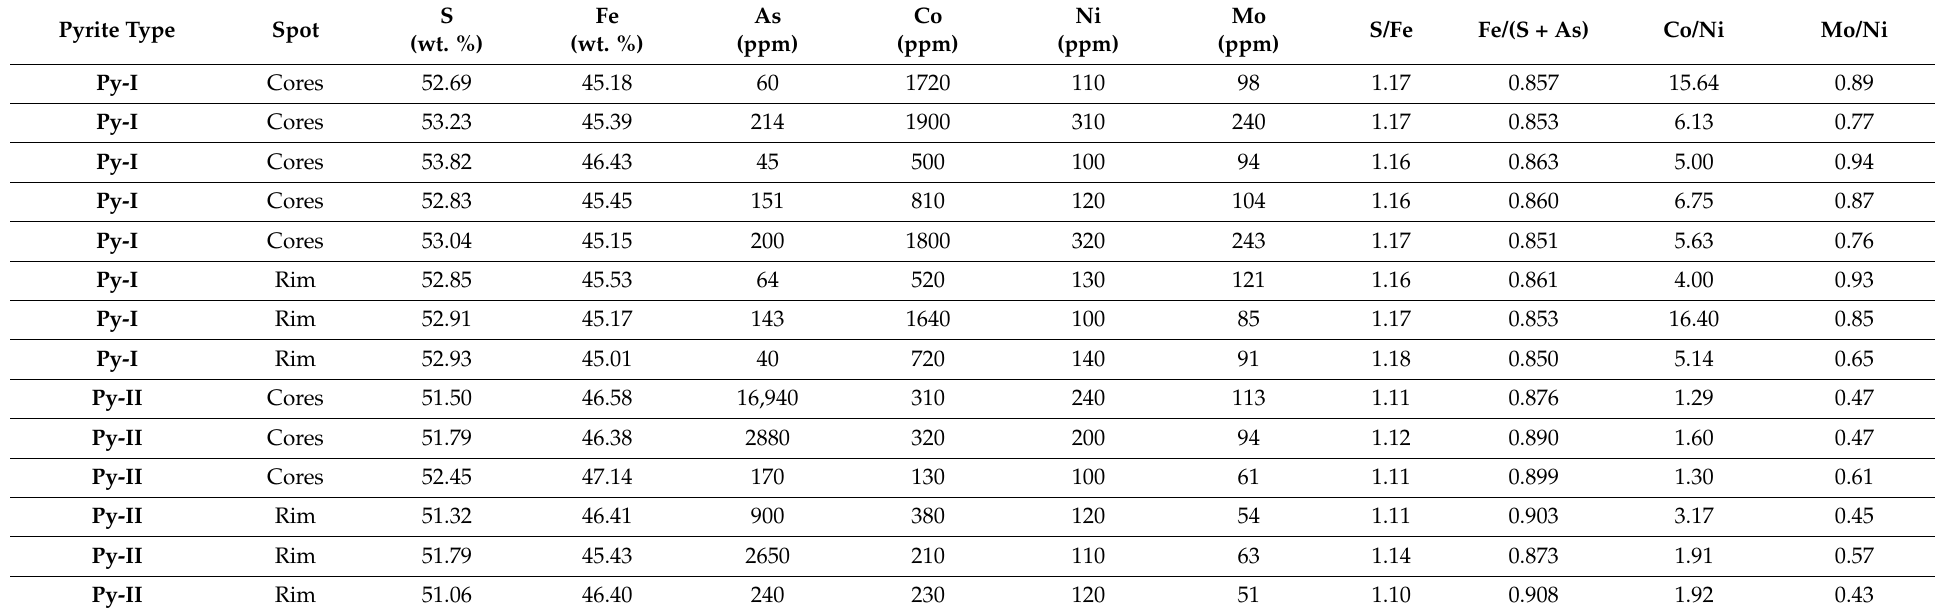
Table 3. S/Fe, Fe/(S + As), Co/Ni, and Mo/Ni pyrite ratios in the Kargah Cu-Pb polymetallic